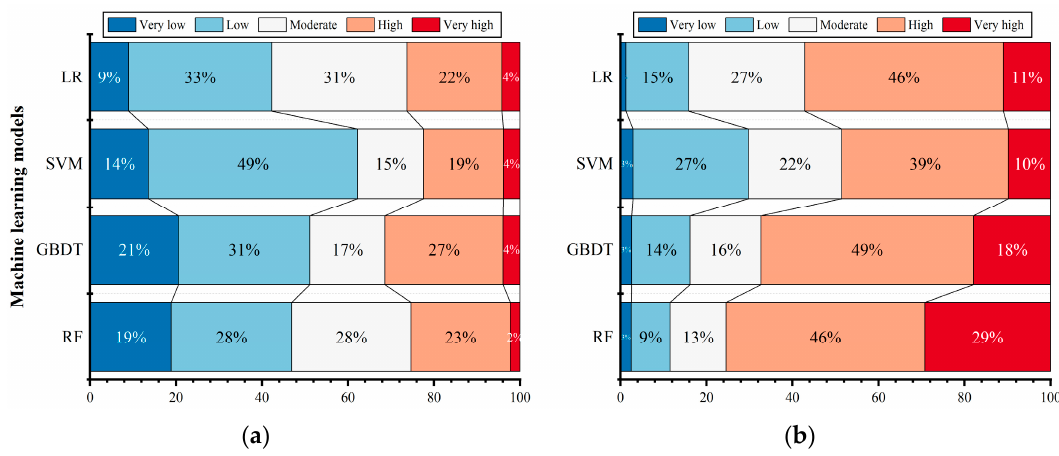
Figure 9. Landslide susceptibility map based on different machine learning models.